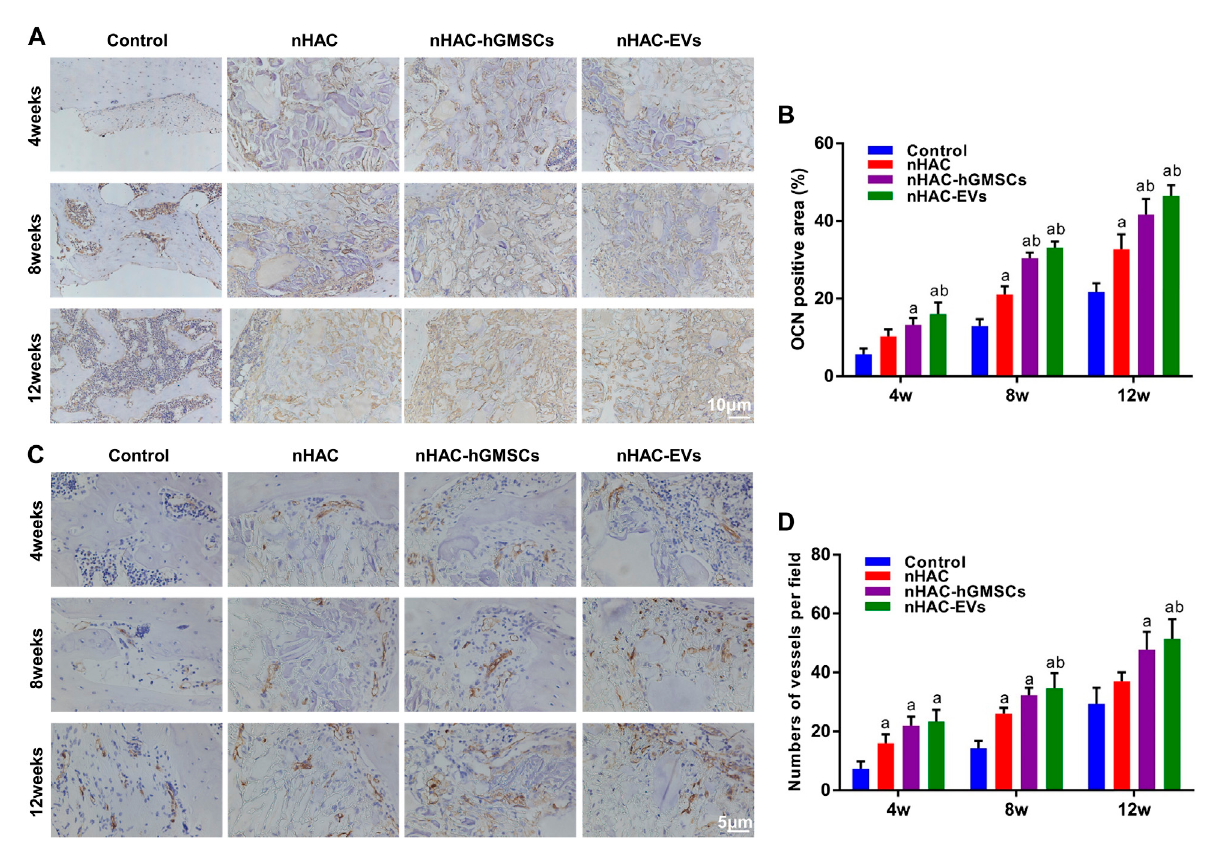
FIGURE 9 Immunohistochemical staining results ofbone regeneration (A) Representative imagesofOCN staining (B) Quantitativeanalysis ofOCN expression (C) Representative images of CD34 staining (D) Quantitative analysis of CD34 expression. a, p < 0.05 compared with the control group; b, p < 0.05 compared with the nHAC